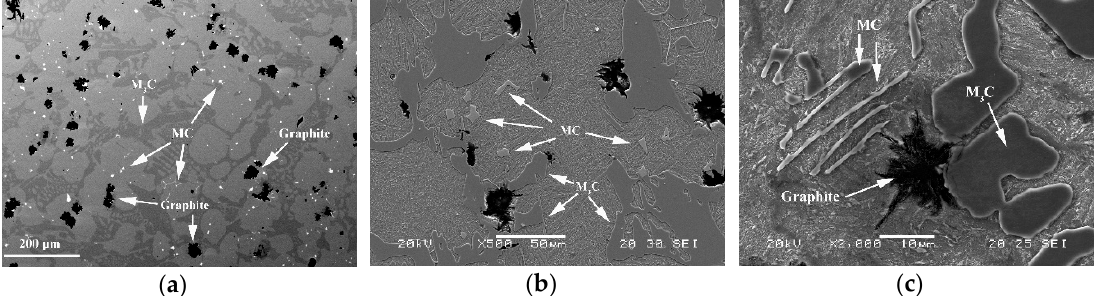
Figure 1. General microstructure of alloys of this type: ( a ) Micrograph obtained using an electronic microprobe, corresponding to Zone β in Experiment 2; ( b ) Micrograph obtained using a scanning electron microscope, corresponding to Zone β in Experiment 3; ( c ) Micrograph obtained using a scanning electron microscope, corresponding to Zone α in Experiment 6.